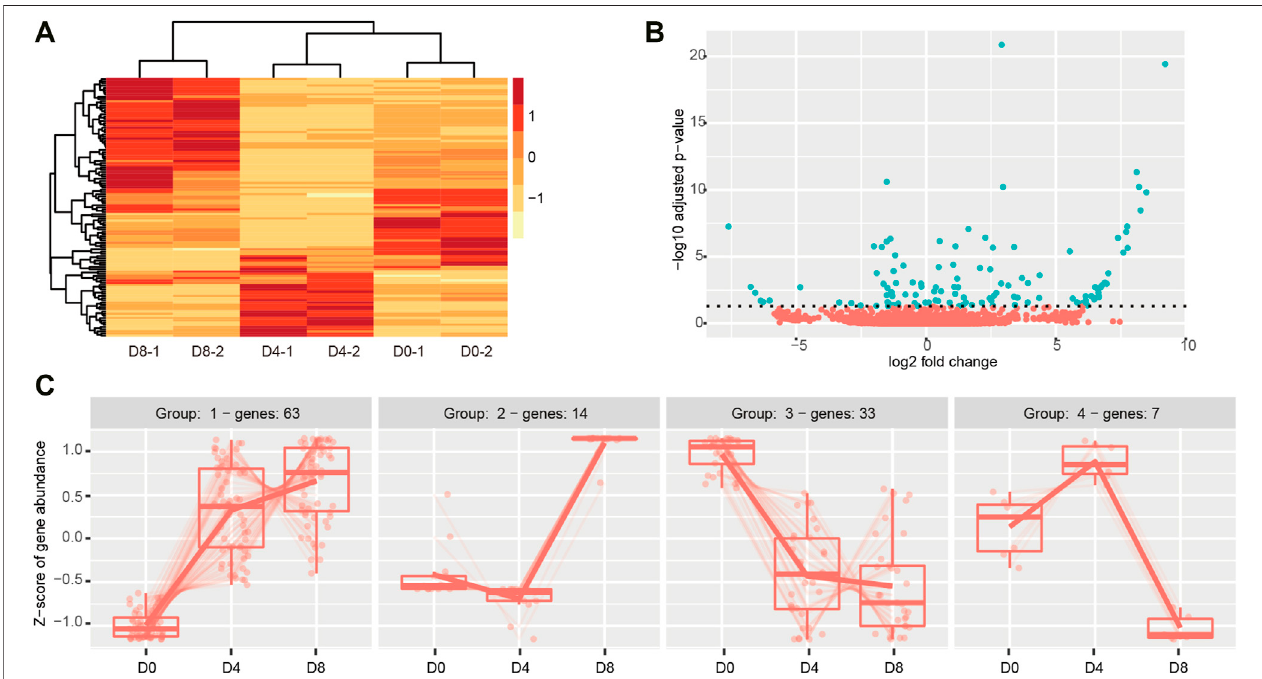
FIGURE 4 | Dynamic differentially expressed circRNAs in brown adipogenesis. (A) Heatmap of DECs across different stages of brown adipogenesis. (B) Volcano plotshowingcircRNAabundanceacrossbrownadipogenesis.Thegreencolorpresentsthesigni fi cantchangedDECs(padj < 0.05). (C) ExpressionpatternsoftheDECs analyzed by degPatterns function from the DEGreport package (minc (cid:1)